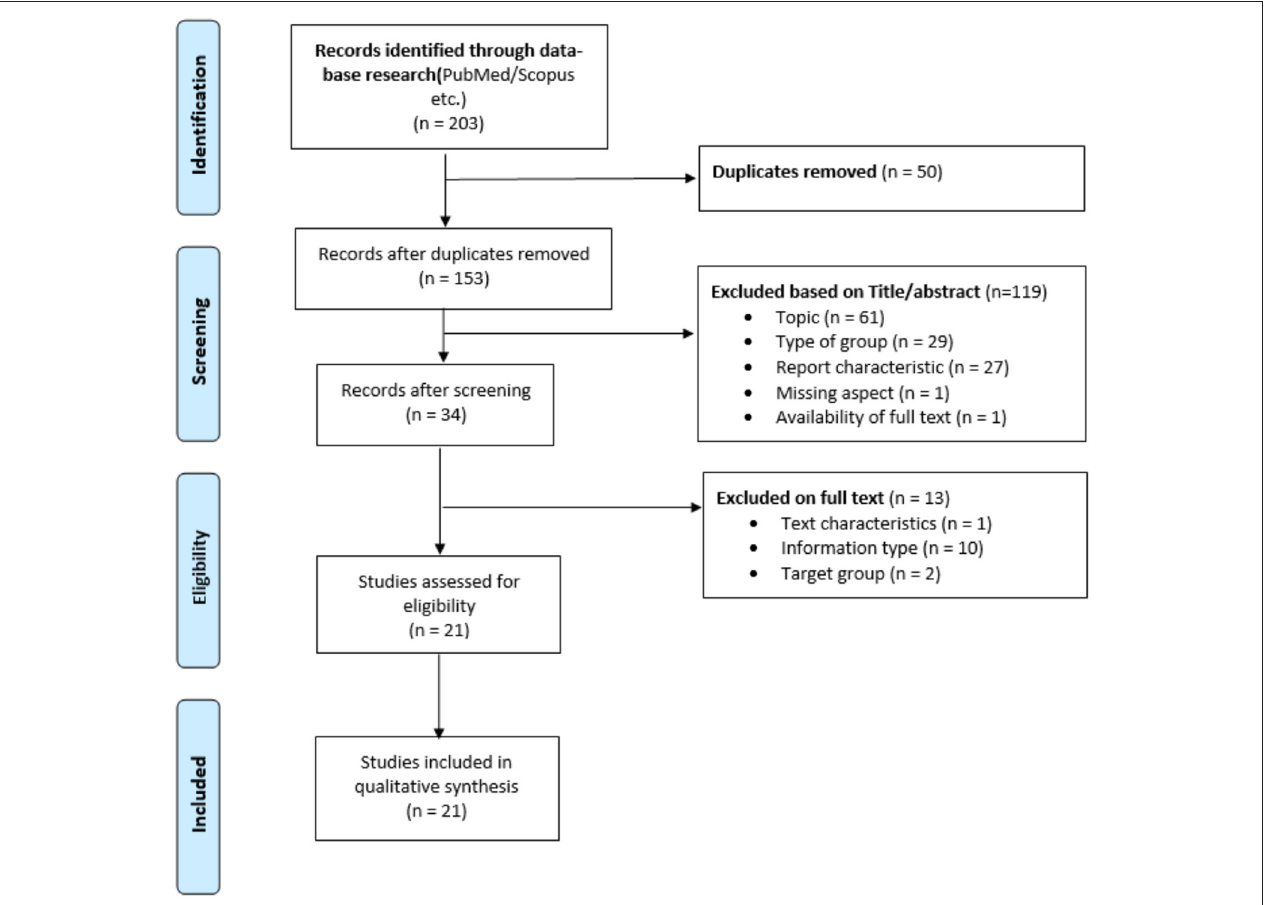
FIGURE 1 | PRISMA flow